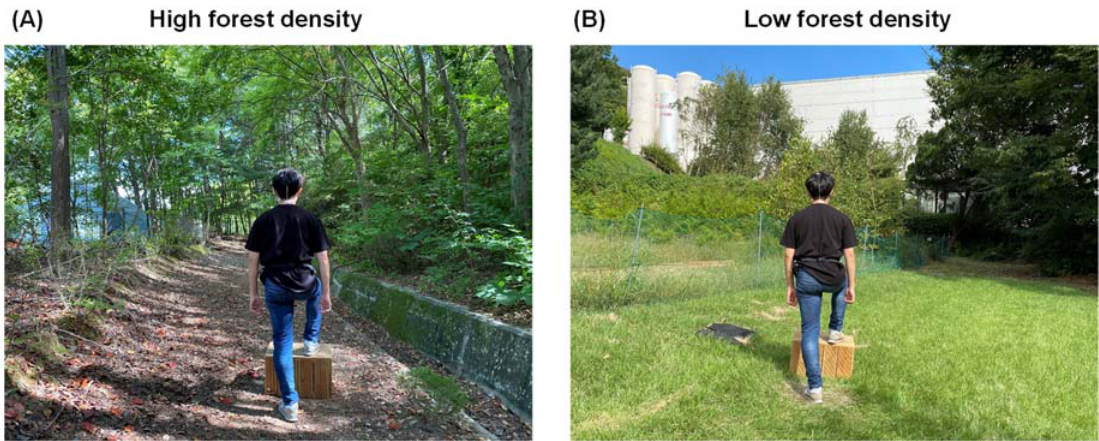
Figure 3. The experimental